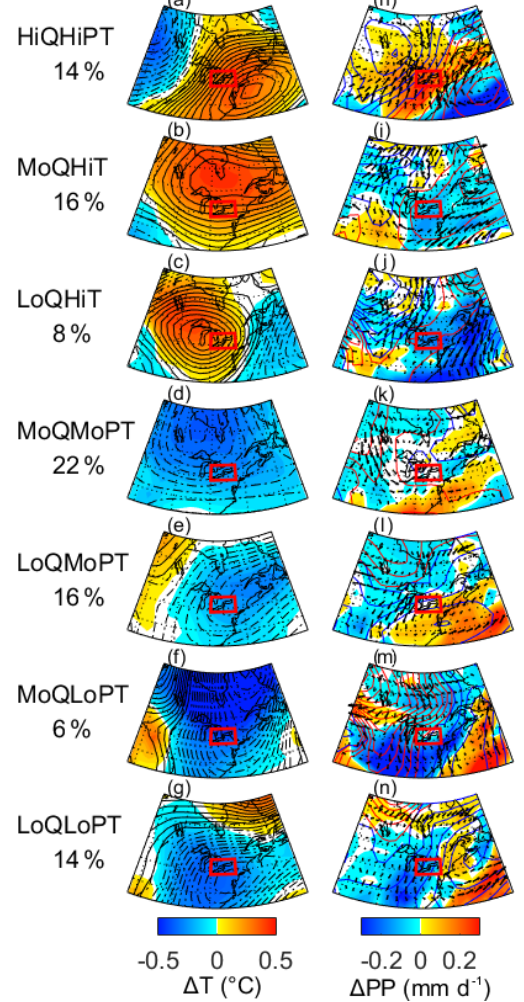
Figure 9. Class average internal contribution of (a–g) T 850 (shade) and Z 500 (black lines, in intervals of 1m) and (h–n) precipitation (shade), SLP (lines, in intervals of 0.1Pa) and wind (vectors) to the 50-member average change between the historical and the 2040s periods in